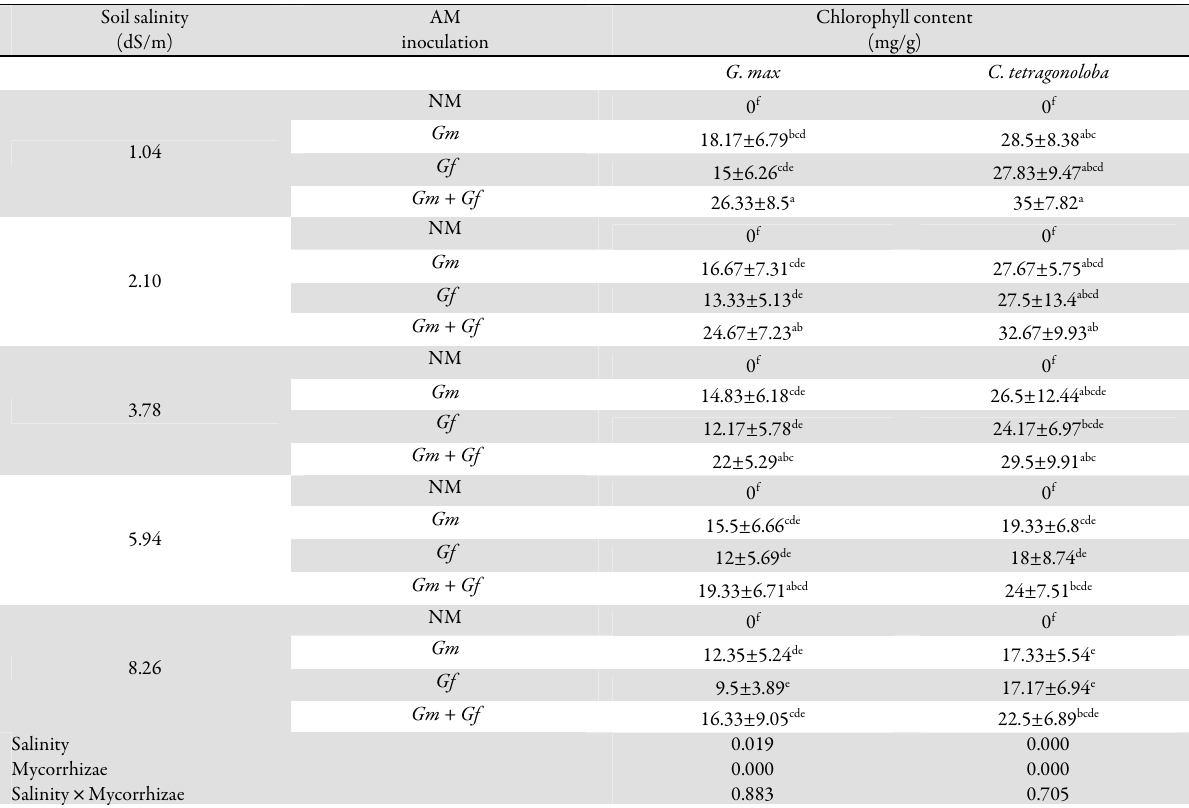
Tab. 8. Percent root colonization of mycorrhizal and non-mycorrhizal G. max and C. tetragonoloba grown under control (1.04 dS/m) and at increasing soil salinity levels (2.10 to 8.26 dS/m) Soil salinity (dS/m)